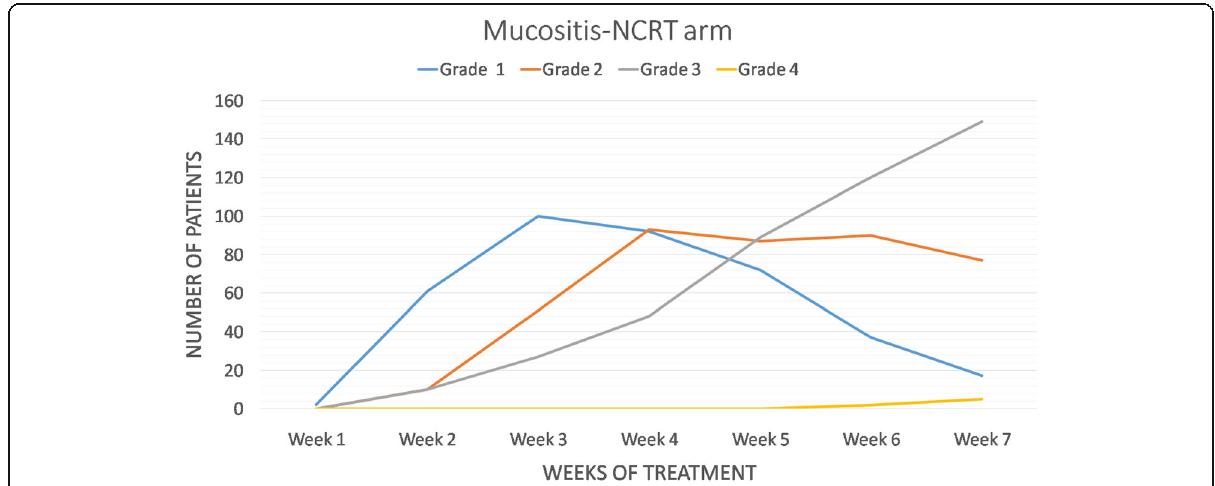
Fig. 4 Temporal evolution of the pattern of mucositis per week in nimotuzumab cisplatin